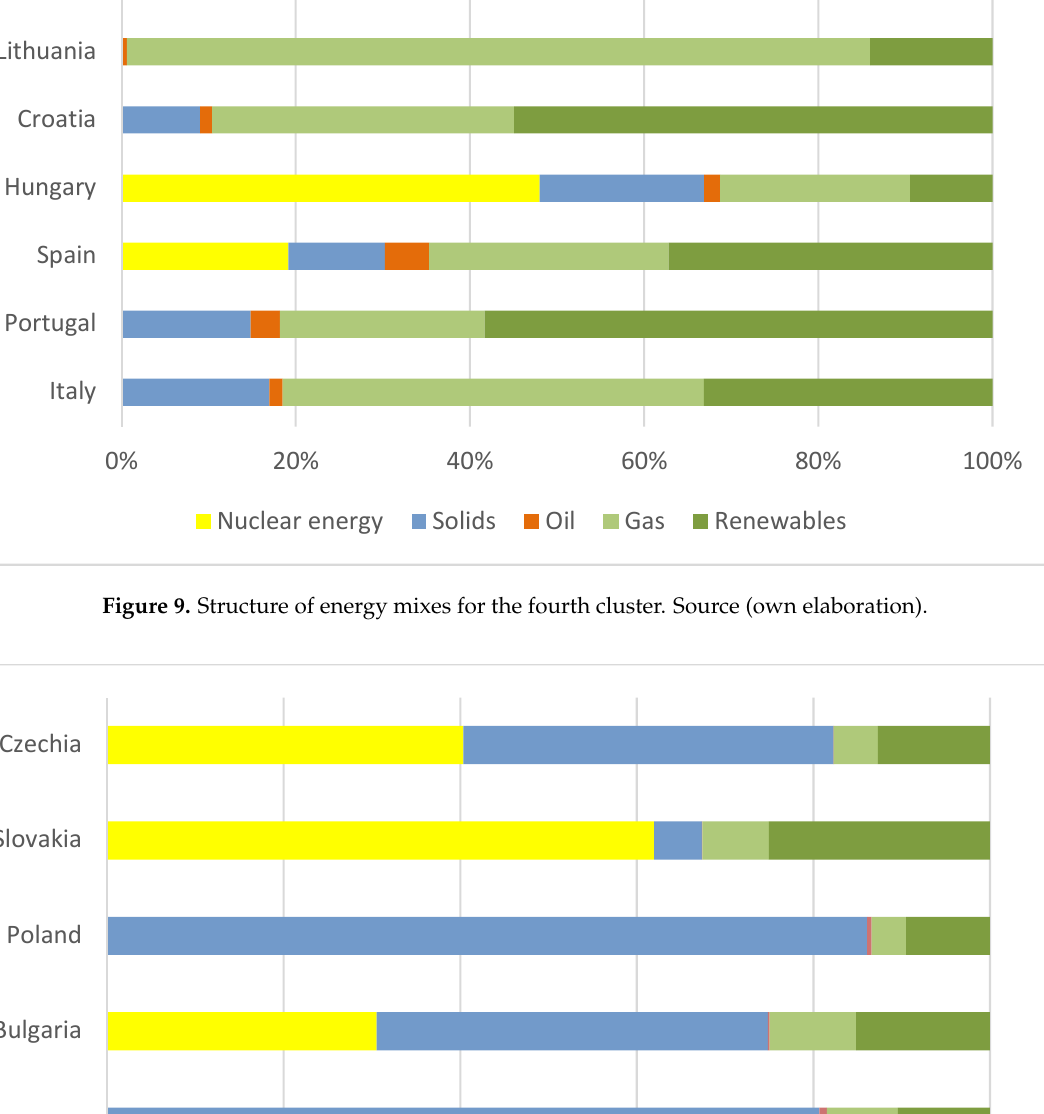
Figure 8. Structure of energy mixes for the third cluster . Source (own elaboration).